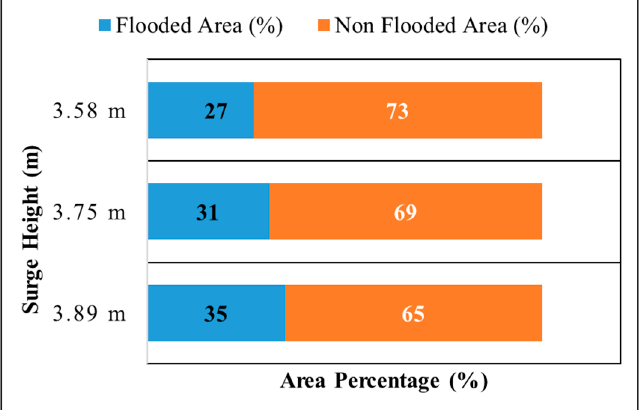
Figure 9. Flooded areas in percentage for different surge heights. Table 4. Flooded and non-flooded areas with different surge heights and